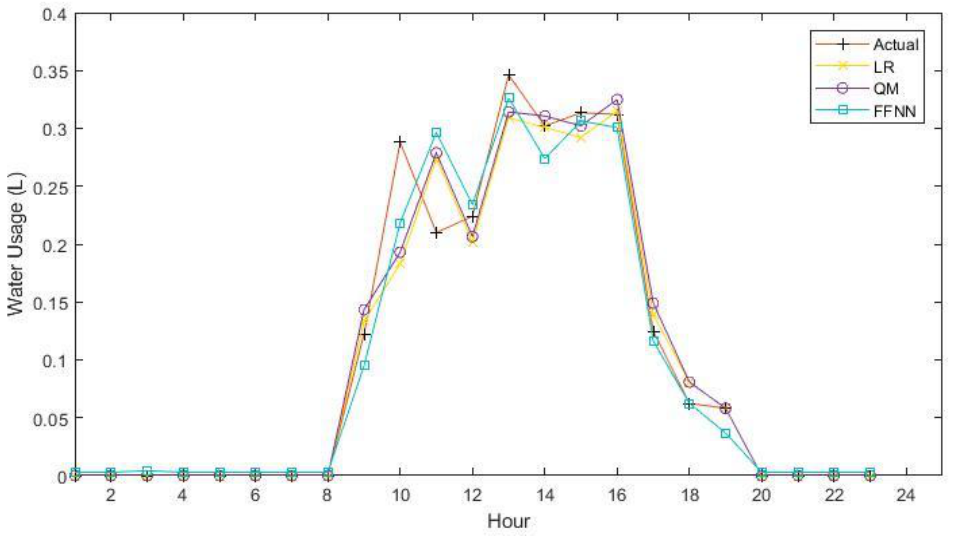
Figure 8. Day-ahead forecast for peppers using base model data.